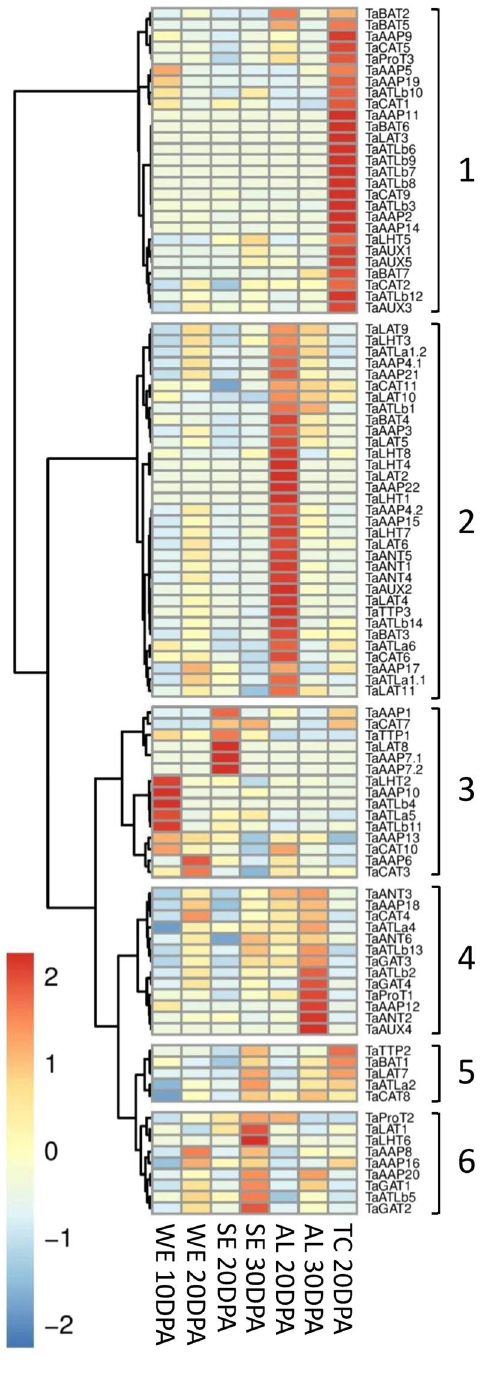
Figure 4. Spatiotemporal expression patterns of AAPs in different grain cells scaled by row in endosperm cells: transfer cell (TC), starchy endosperm (SE), aleurone cell (AL) at 20 and 30 DPA, and whole endosperm (WE) (including TC, SE, and AL) at 10 and 20 DPA. The TC and AL cells might be contaminated by SE tissue and result in high expression for AATs highly expressed in